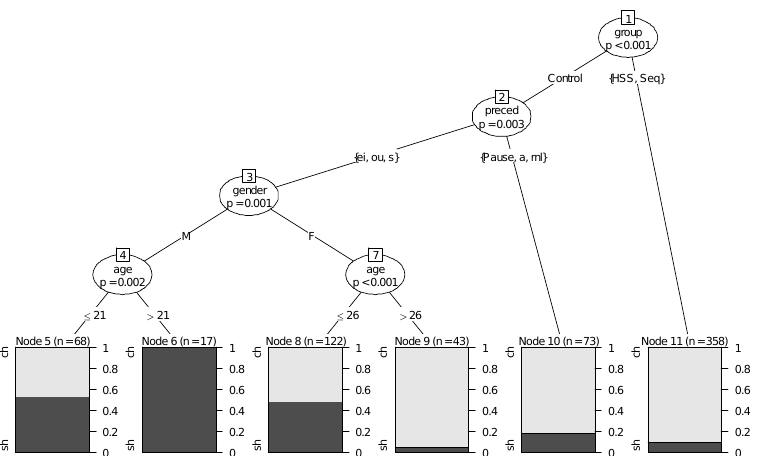
Figure 7. Random forest including individual speaker, group, the linguistic factors (preceding seg- ment, following segment, position in the word, and stress) and the extra-linguistic factors (gender, age, and style).